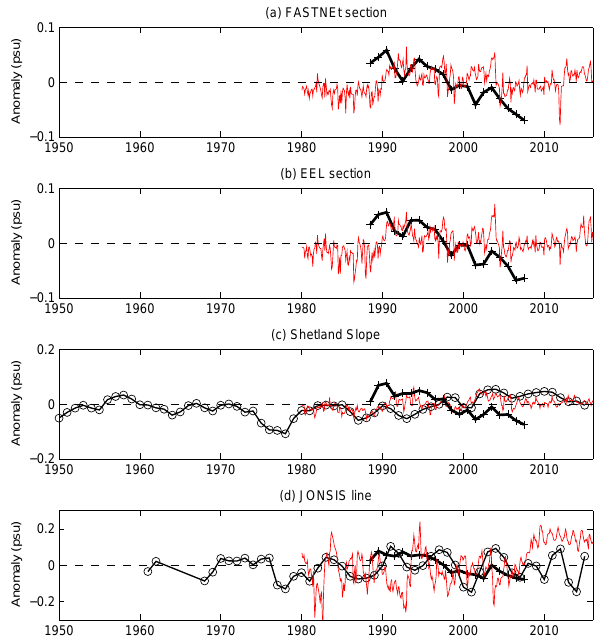
Figure 12. Annual and monthly mean salinity anomalies (relative to the length of each time series), from observations (thin lines) and in ORCA12-N01 (thick lines), at each section: (a) FASTNEt; (b) EEL; (c) Shetland Slope; and (d) JONSIS. The thin red lines are obtained by subtracting climatological seasonal cycles from salin- ity in the NCEP Global Ocean Data Assimilation System (GO- DAS) analysis fields, sampled at the following locations: 9.5 ◦ W, 55.83 ◦ N at 100m (FASTNEt); 9.5 ◦ W, 57.17 ◦ N at 100m (EEL); 2.5 ◦ W, 60.83 ◦ N at 100m (Shetland Slope); 1.5 ◦ W, 59.17 ◦ N at 50m (JONSIS) – see Figs. S10, S11. The thin black curves in (c, d) are observations for the FSC Shetland Shelf and the Fair Isle Cur- rent (see Sect. 2.1).